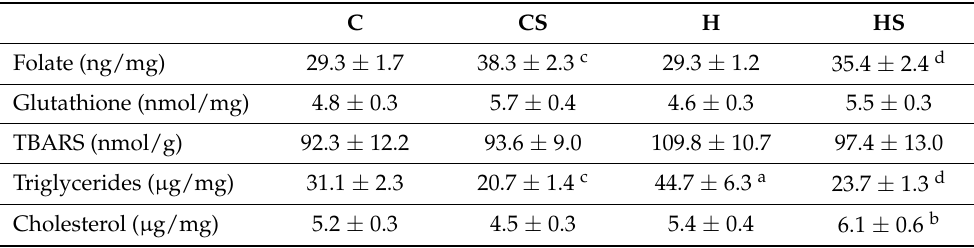
Table 4. Hepatic parameters at endpoint (30.5